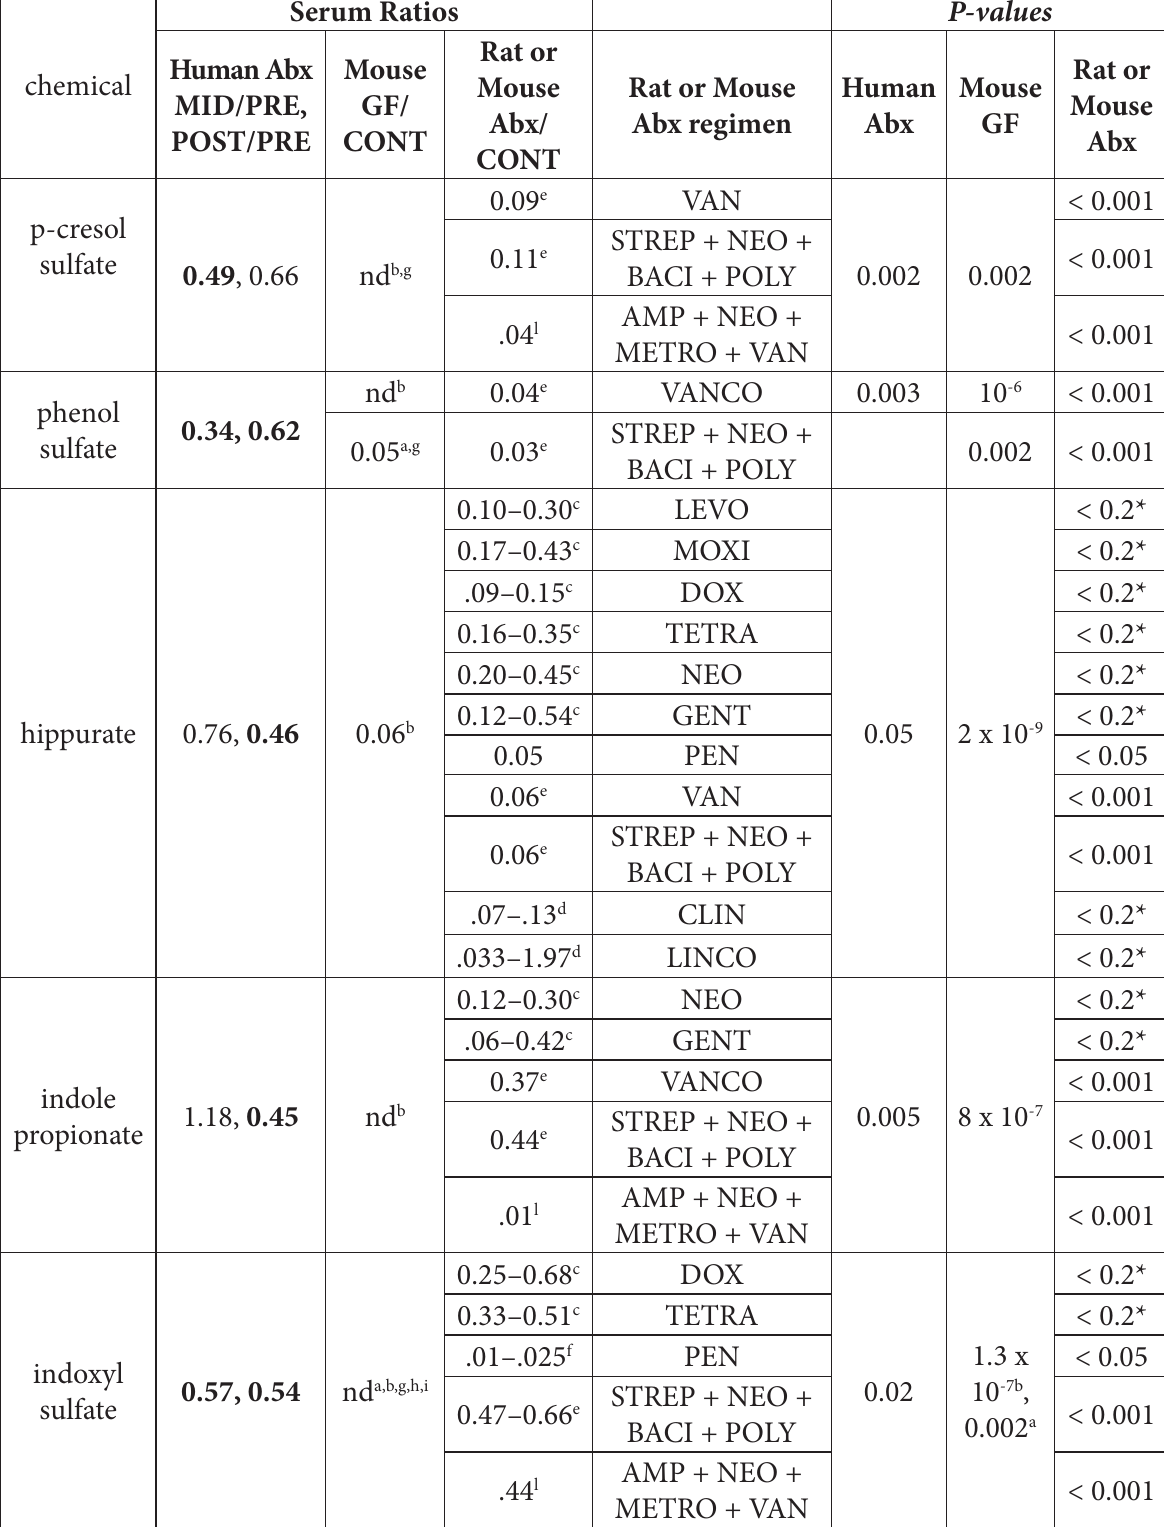
Table 3: Effects on Serum Levels of Small Molecules: Antibiotics in Patients vs Germ-Free Status or Antibiotics in Animal